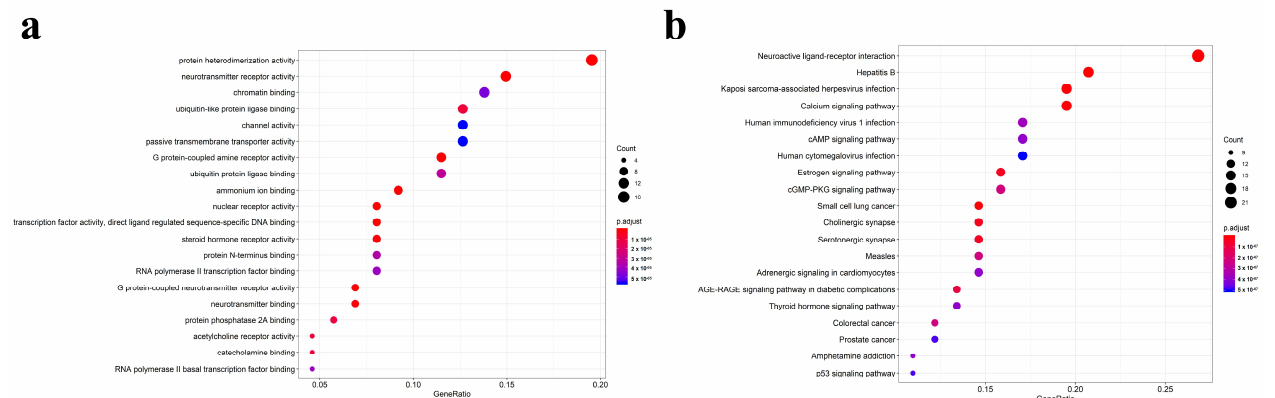
Figure 4. GO and KEGG diagram of targets. ( a ) GO function enrichment analysis result point chart. The size of the circle in the figure indicates the number of targets participating in this function, and the reddish color indicates the smaller the p-value, otherwise vice versa. ( b )The results of the KEGG pathway enrichment analysis were plotted. The size of the circle in the picture indicates the number of targets participating in the path, and the reddish color indicates the smaller the p -value, otherwise vice versa.